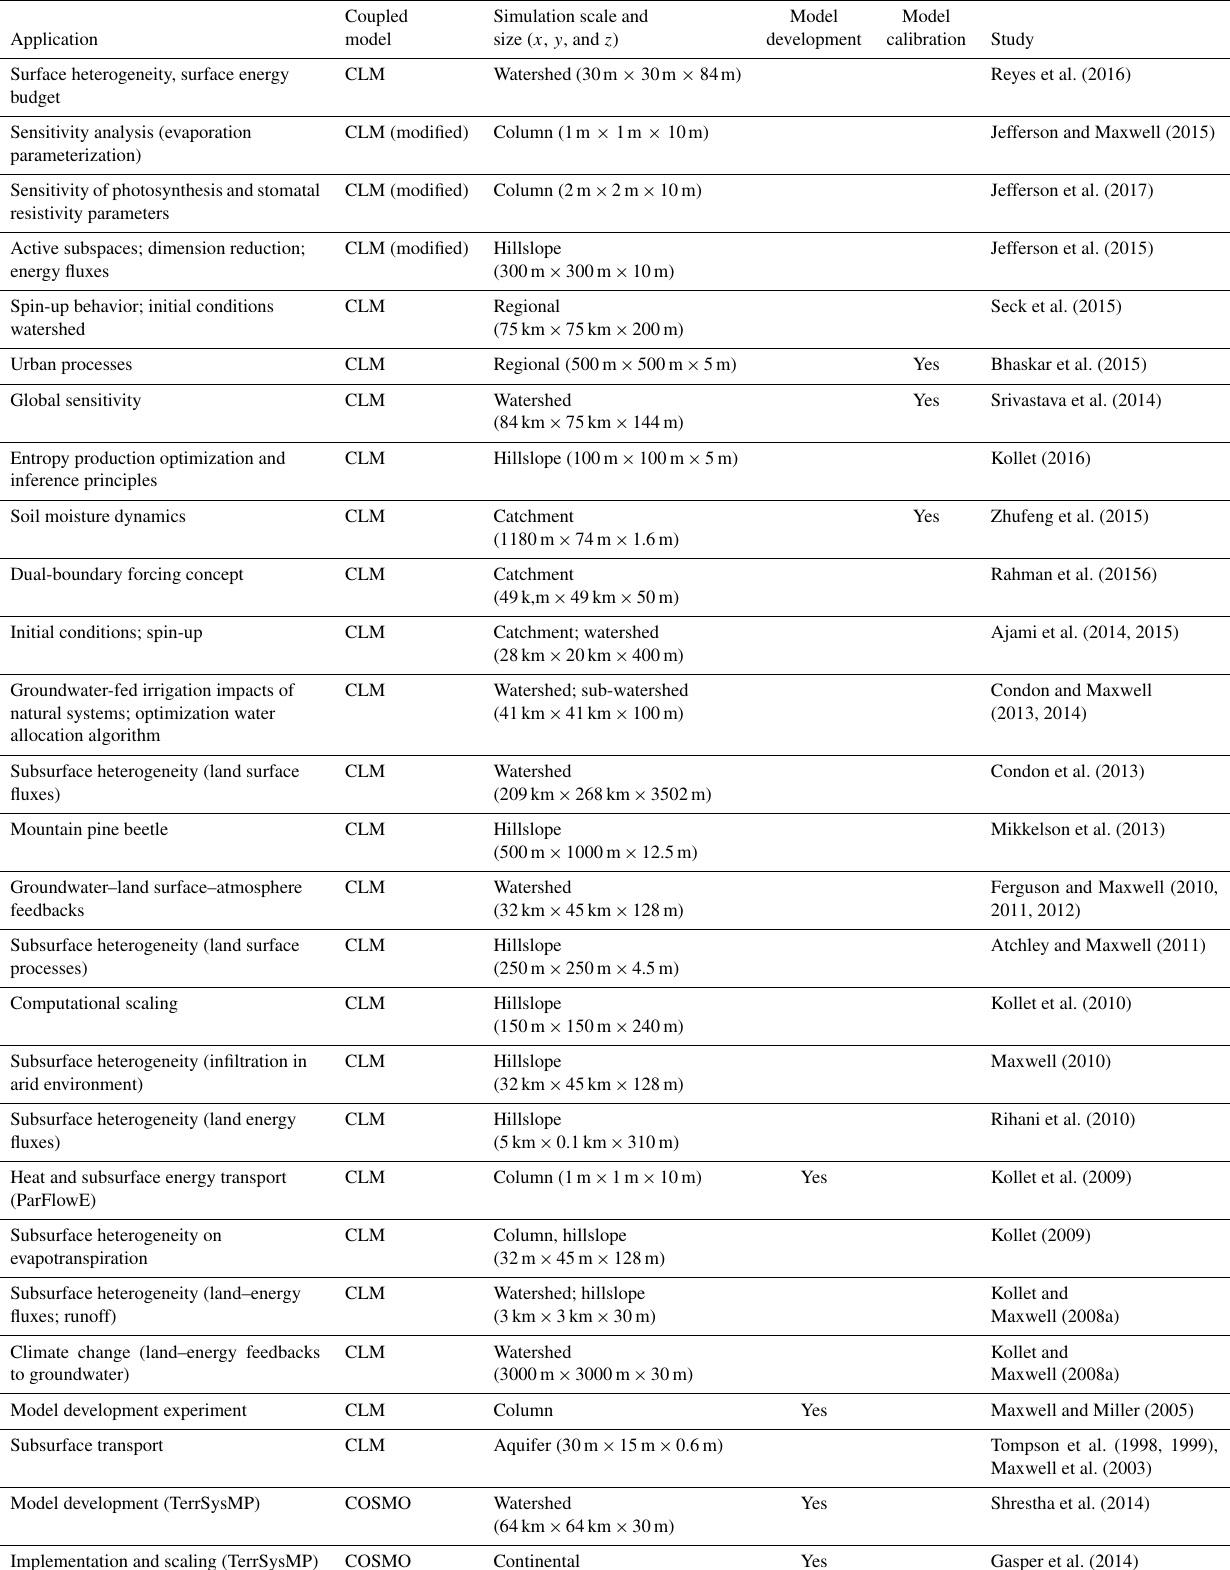
Table 2. Selected coupling studies involving the application of ParFlow and atmospheric, land surface, and subsurface